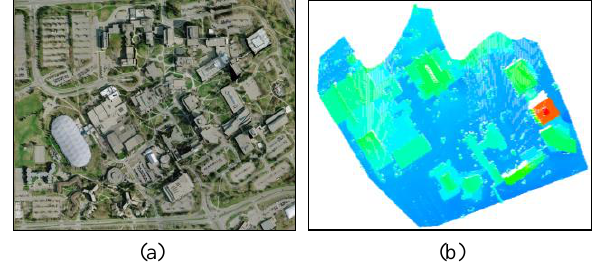
Figure 13. (a) An aerial photo and (b) and airborne laser scanning data colored according to height over the area of interest (University of Calgary campus)